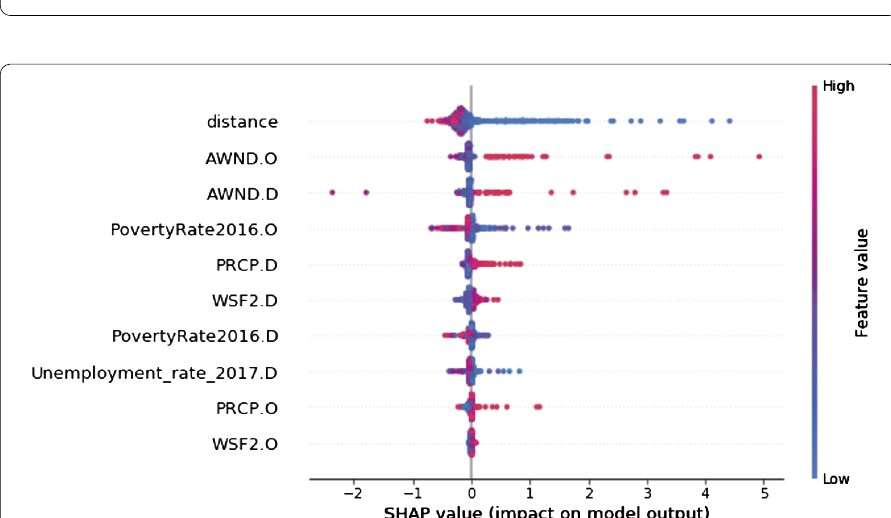
Figure 9 SHAP values of the top 10 Features. (X.O refers to features of origin county, X.D refers to features of destination